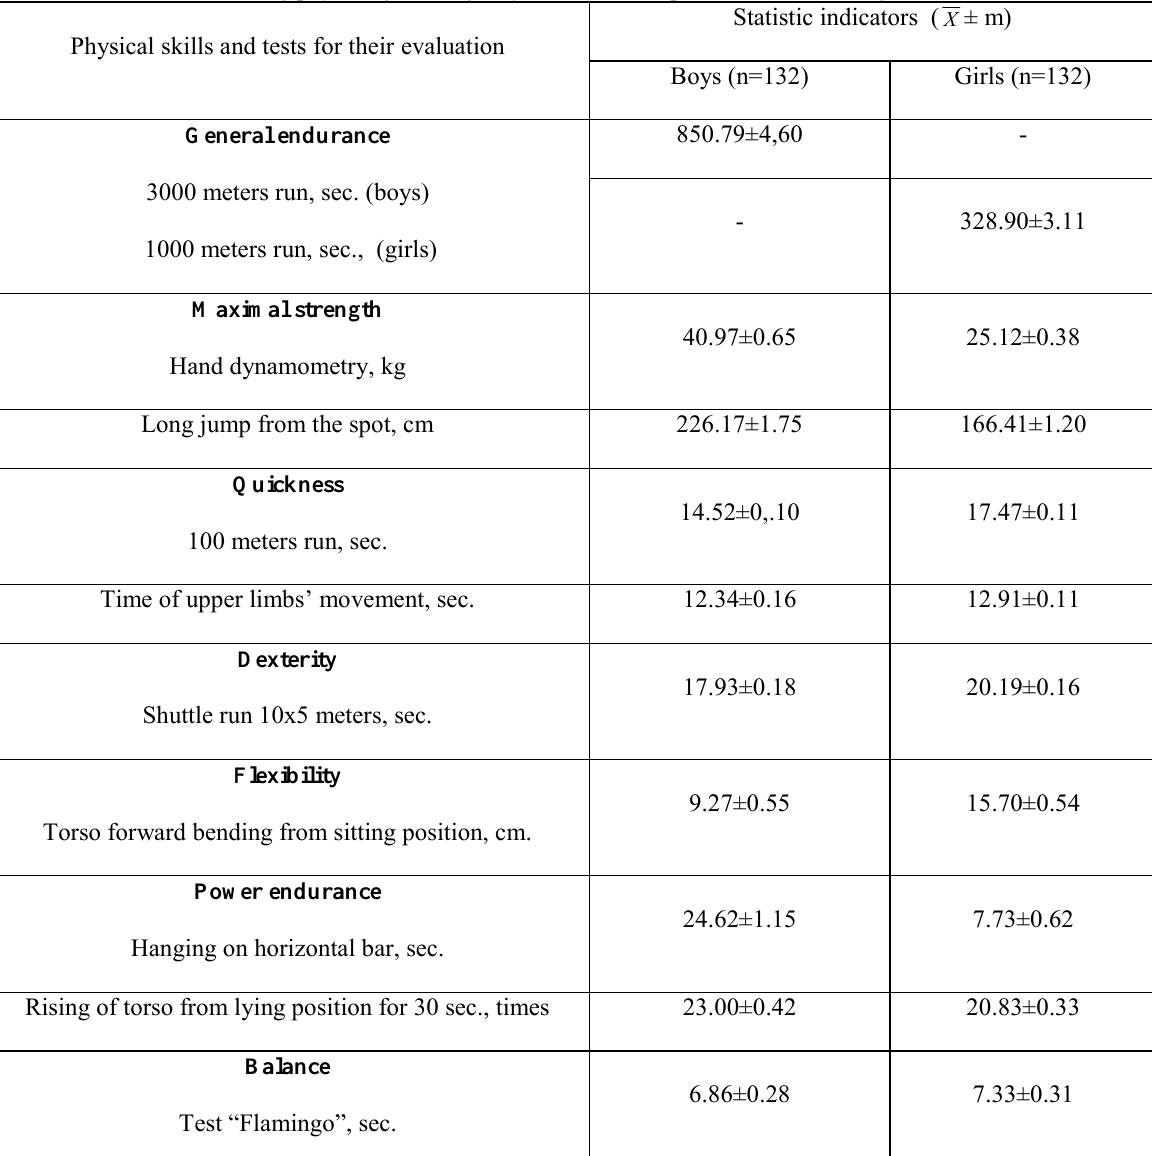
Indicators of physical fitness of 1 st year technical specialties’ students of SumDU Physical skills and tests for their